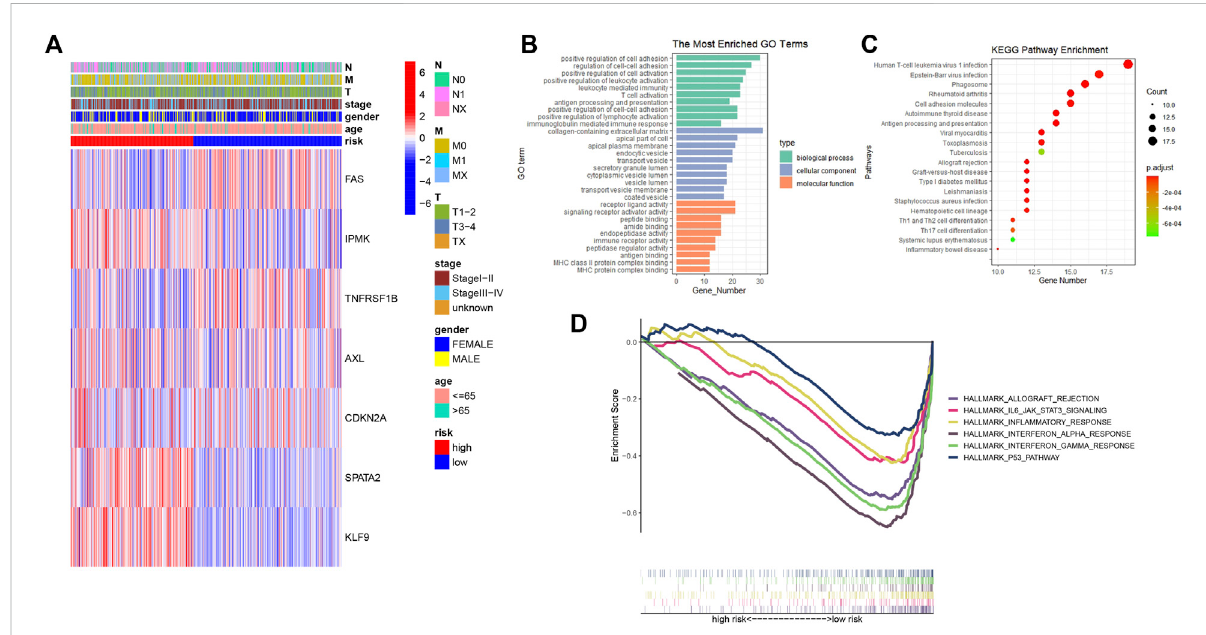
FIGURE 5 (A) Heatmap showing the connections between clinicopathologic factors and high- and low-risk groups; (B) Bar chart for GO enrichment of DEGs between high- and low-risk; (C) Bubble graph for KEGG pathways of DEGs between high- and low-risk; (D) Gene set enrichment analysis (GSEA) showed the signi fi cantly enriched hallmarks of tumor sets based on the risk signature in